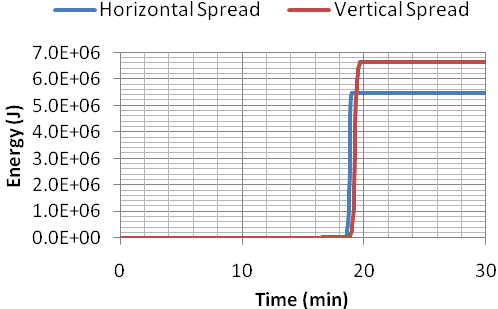
Fig. 15. Time-history of plastic dissipation energy in 5-storey frame.